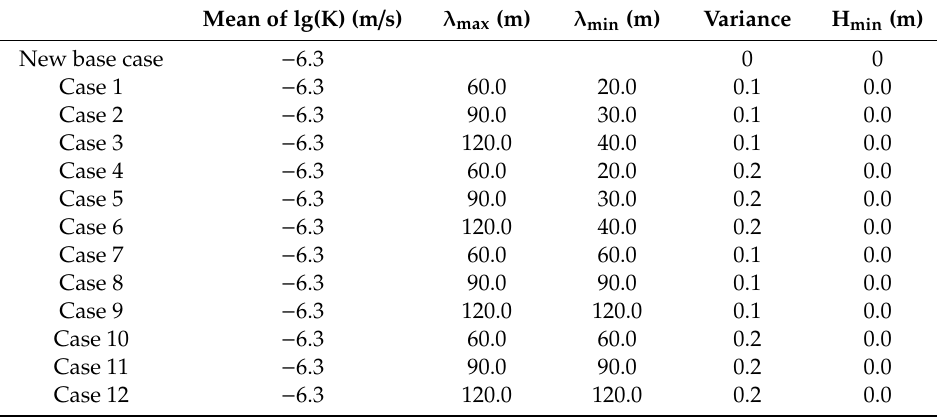
Table 2. Parameters that were used for the heterogeneous